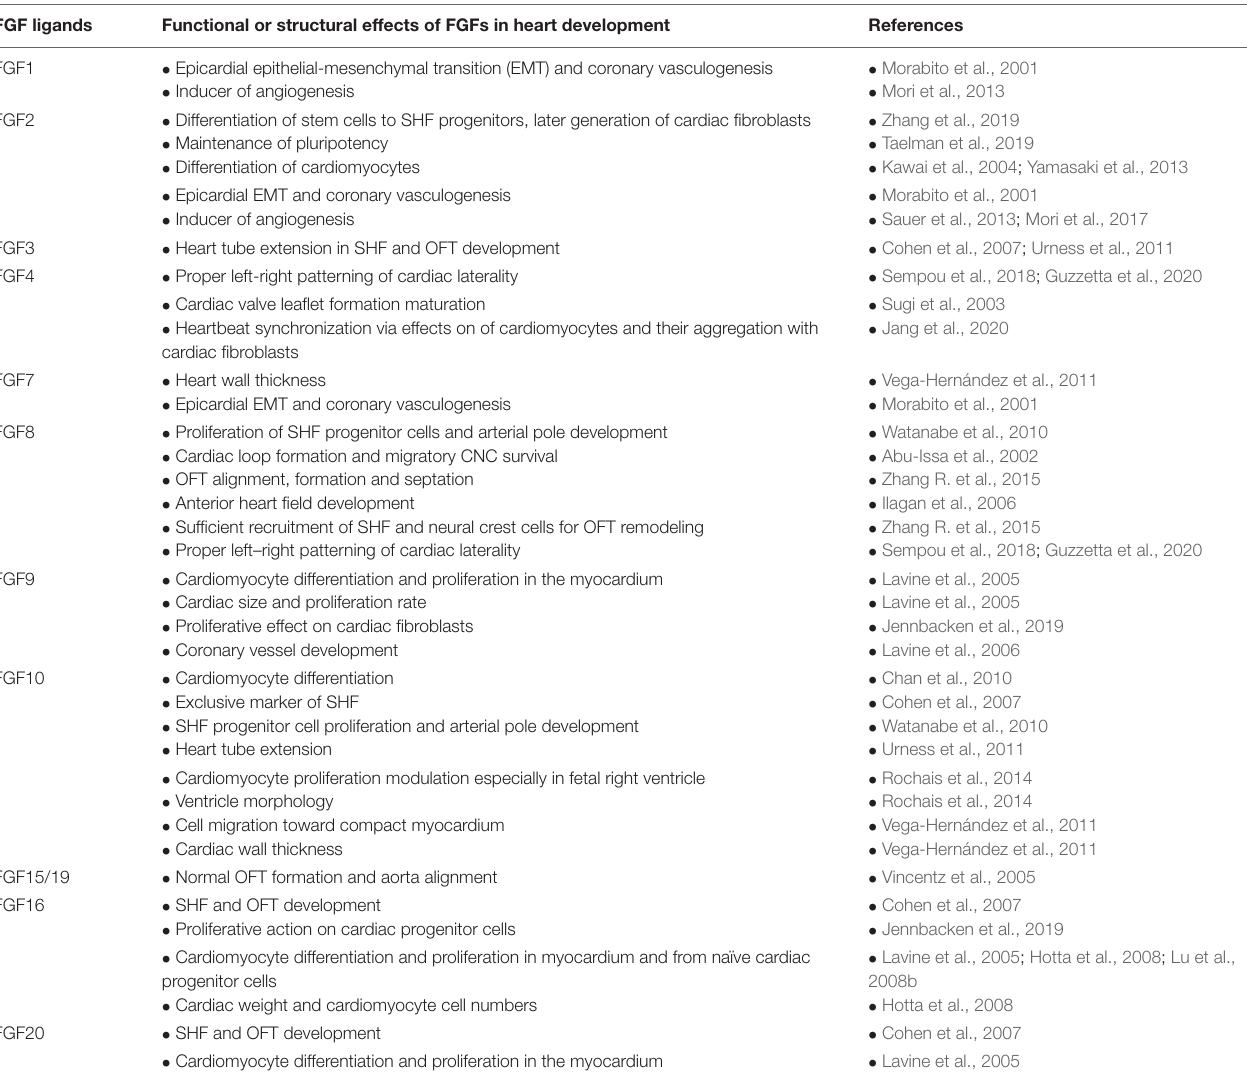
TABLE 1 | Roles of secreted FGFs in heart